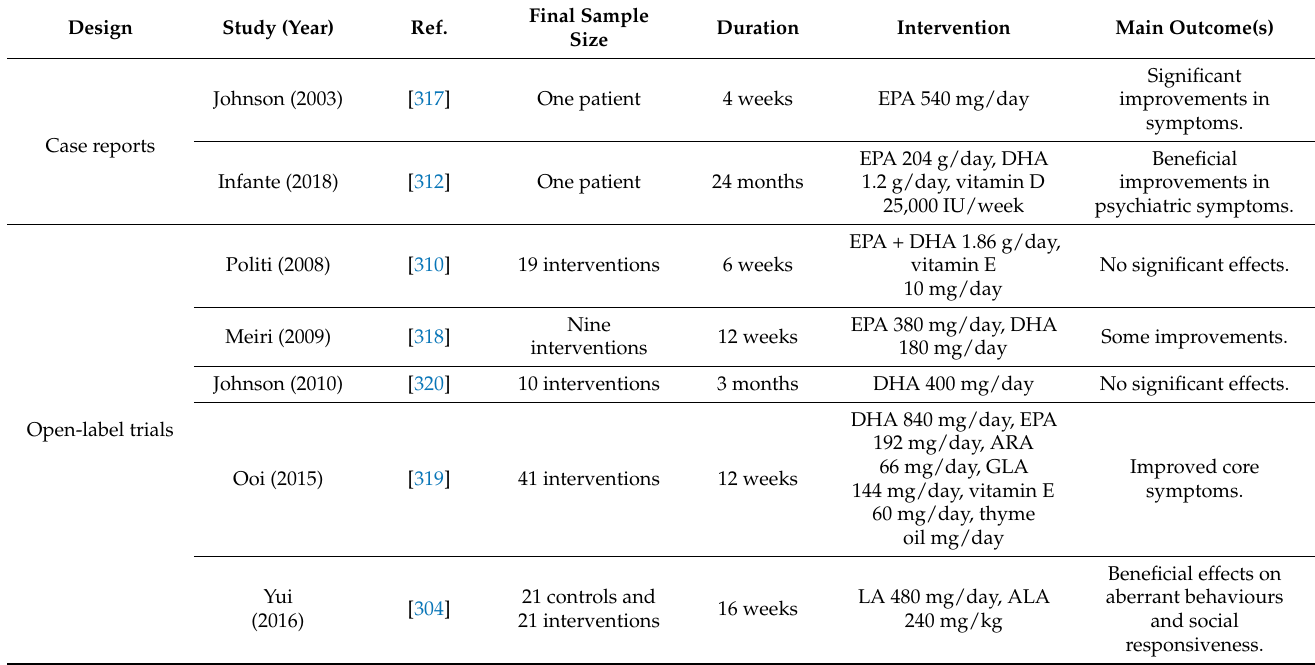
Table 2. Interventional studies using LC PUFAs in patients with autistic spectrum disorder (ASD) or ASD-like symptoms. ALA: α -linolenic acid; ARA: arachidonic acid; DHA: docosahexaenoic acid; EPA: eicosapentaenoic acid; GLA: γ -linolenic acid; LA: linoleic acid, n-9: n-9